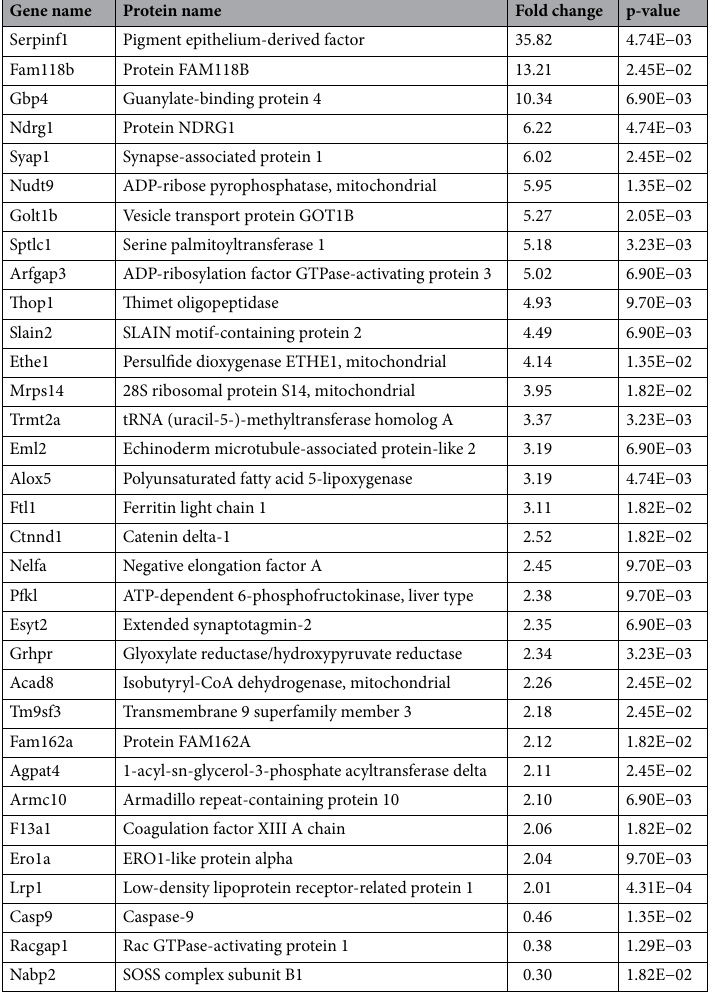
Table 1. Effect of collagen type I on macrophage protein expression. 30 proteins were expressed at levels more than twofold higher by macrophages cultured on collagen type I-coated plastic (fibrous and globular combined, n = 6 each), compared to macrophages cultured on uncoated plastic (n = 6). Three proteins were expressed at levels more than twofold lower (fold change < 0.5). p < 0.025 was considered